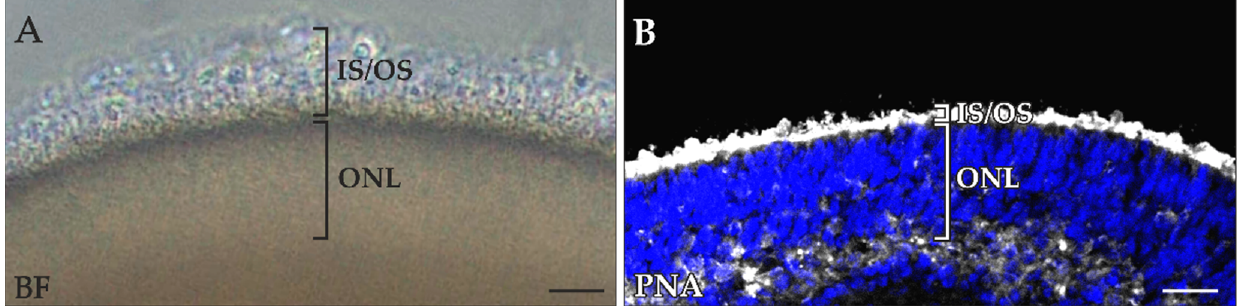
Figure 1. Photoreceptor inner (IS) and outer (OS) segments were lost during retinal organoid (RO) processing. ( A ) Brightfield (BF) image and ( B ) peanut agglutinin (PNA)-positive photoreceptor IS and OS of the same 180-day-old RO after PNA-staining. Prior to processing, ROs revealed IS and OS outgrowth, but upon harvesting and PNA-staining of the RO, the IS/OS layer was considerably reduced, in contrast to the outer nuclear layer (ONL), which remained unaltered in thickness. Counterstaining was performed with 4 ′ ,6 ‐ Diamidin ‐ 2 ‐ phenylindol (Dapi) dye. Scale bars: 25 μ m.